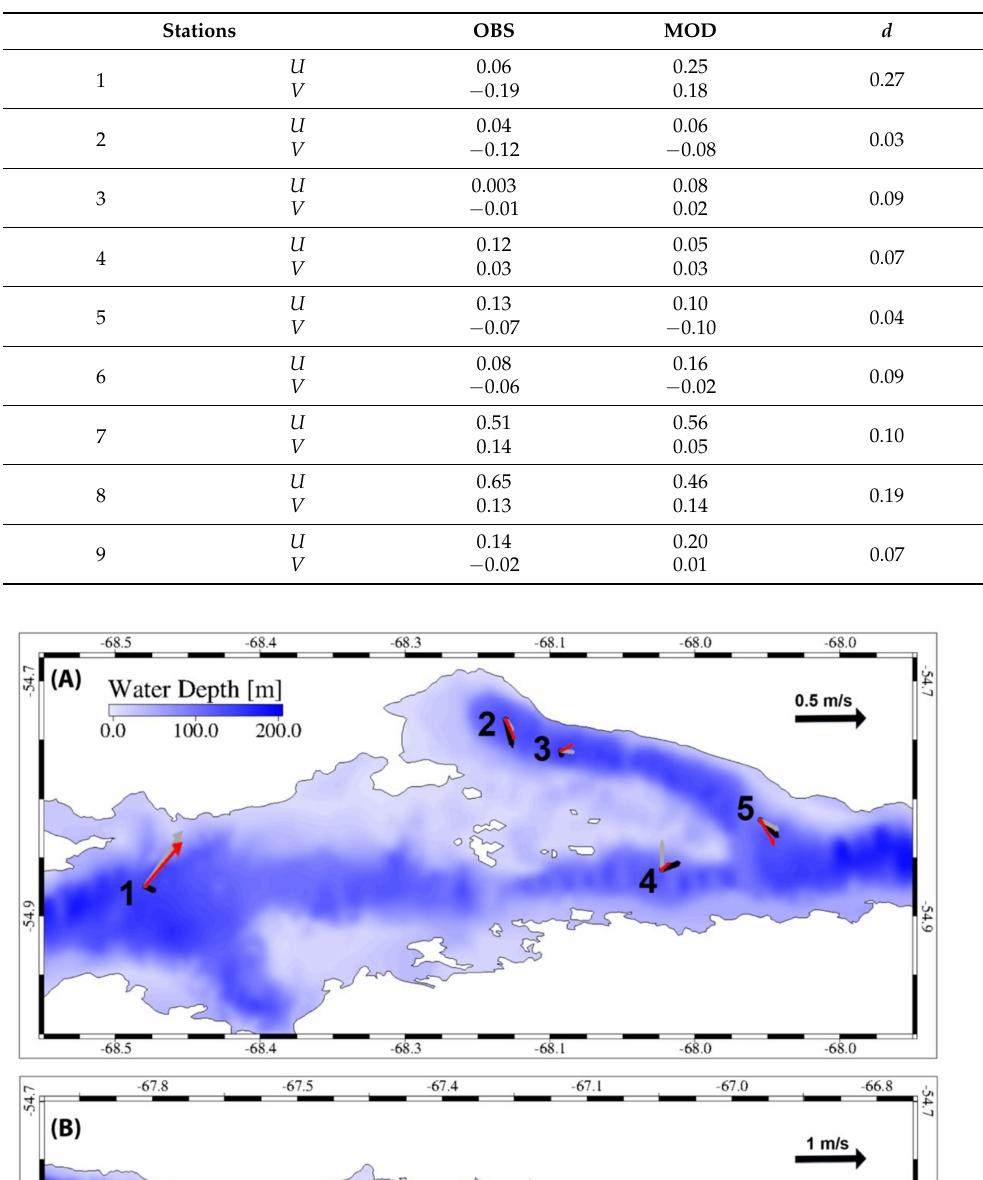
Table 2. Errors and statistics of the model results: observed (OBS) and modeled (MOD) horizontal components of the surface current speeds for the 9 LADCP stations; vectorial differences (d) between observed data (OBS) and model results (MOD).